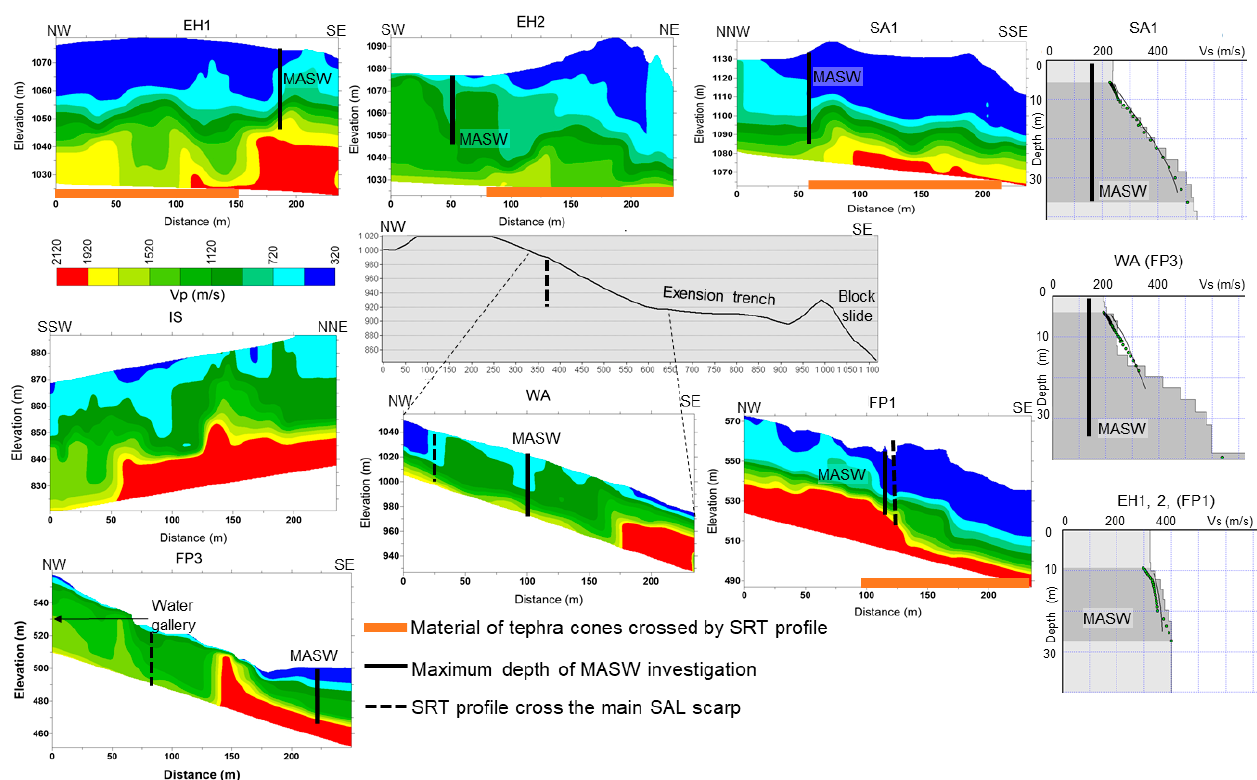
Figure 4. The SRT and MASW results (for location see Figure 2). The topographic profile in the center of the figure provides the geomorphological contexts for the WA profile.